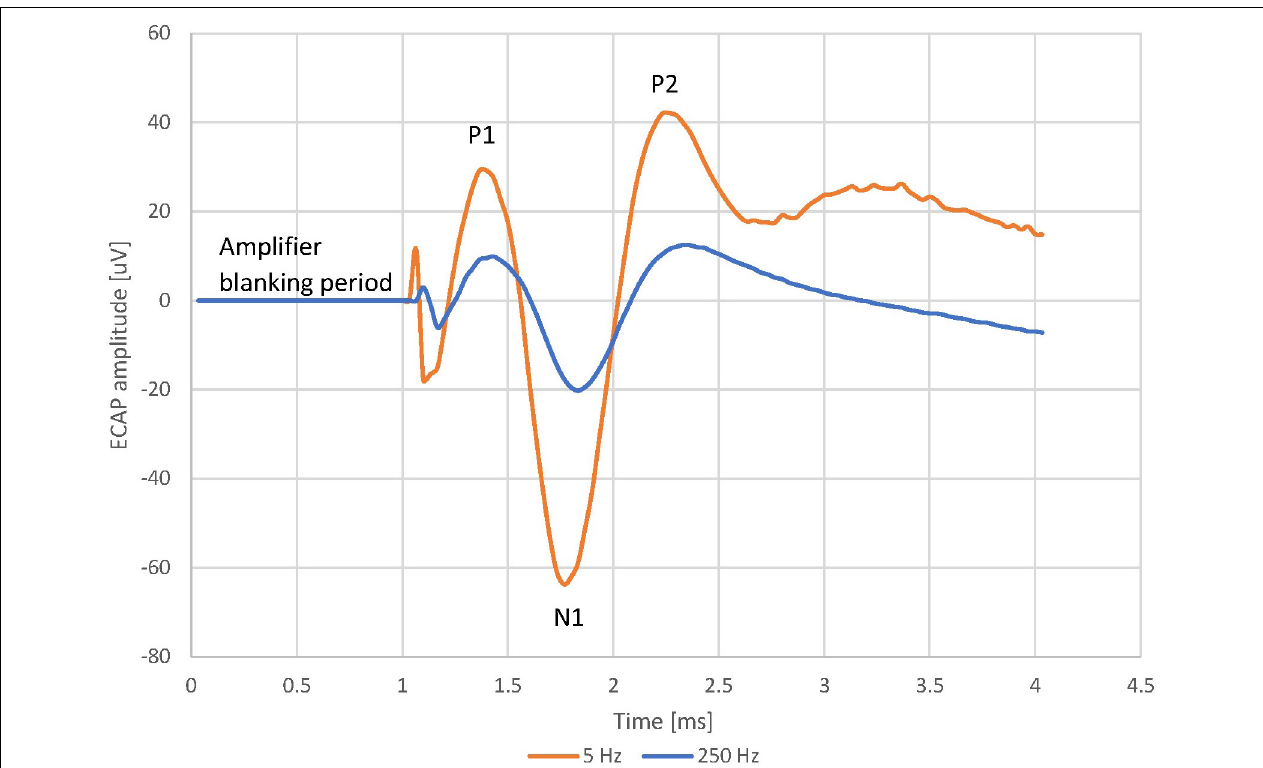
FIGURE 2 | Evoked Compound Action Potential in Patient 13 at 5 and 250 Hz, 7.9 mA stimulus current and 100 us pulse width. The frequency sweep was started at 5 Hz and increased up to 250 Hz before the stimulus became uncomfortable. The patient reported a sensation of 2/10 at 5 Hz and 9/10 at 250 Hz. The voltage between 0 ms (time reference that marks the start of the stimulating pulse) and 1 ms is 0 uV. This “blanking period” is due to the neural amplifiers of the recording system being blanked to avoid saturation while the stimulation pulse is